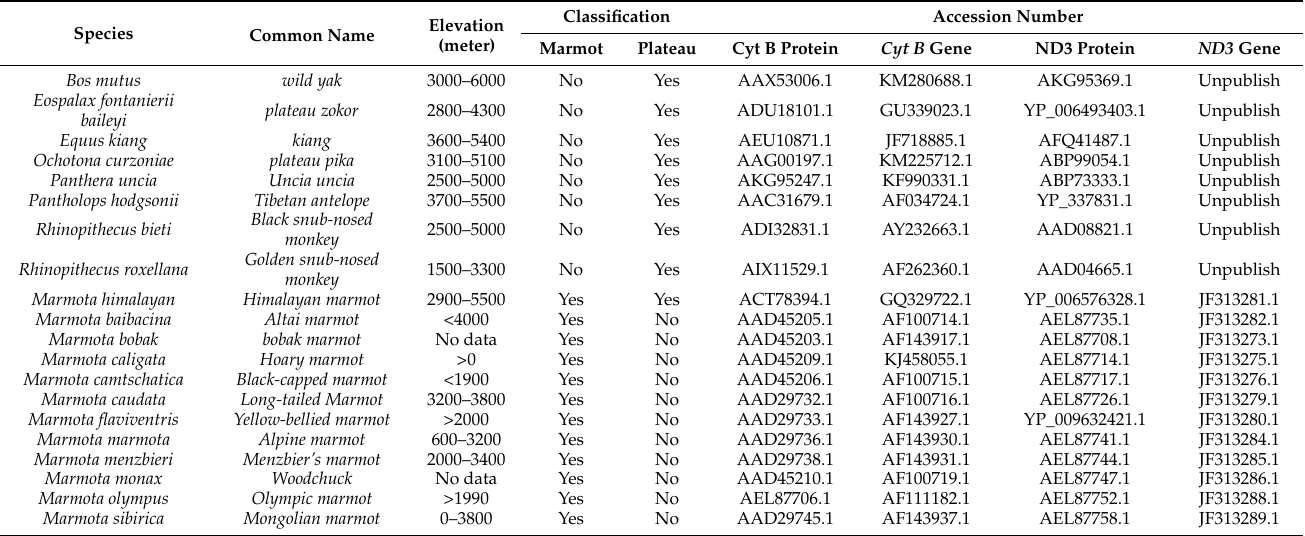
Table 1. The Species and Accession Number of Cyt B and